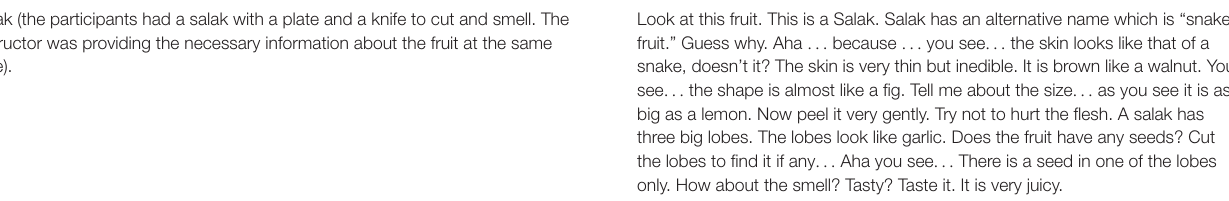
TABLE 2 | A sample instruction for an involved word (using a combination of auditory, visual, and tactile/kinesthetic, olfactory, and gustatory senses). Salak (the participants had a salak with a plate and a knife to cut and smell. The instructor was providing the necessary information about the fruit at the same time).